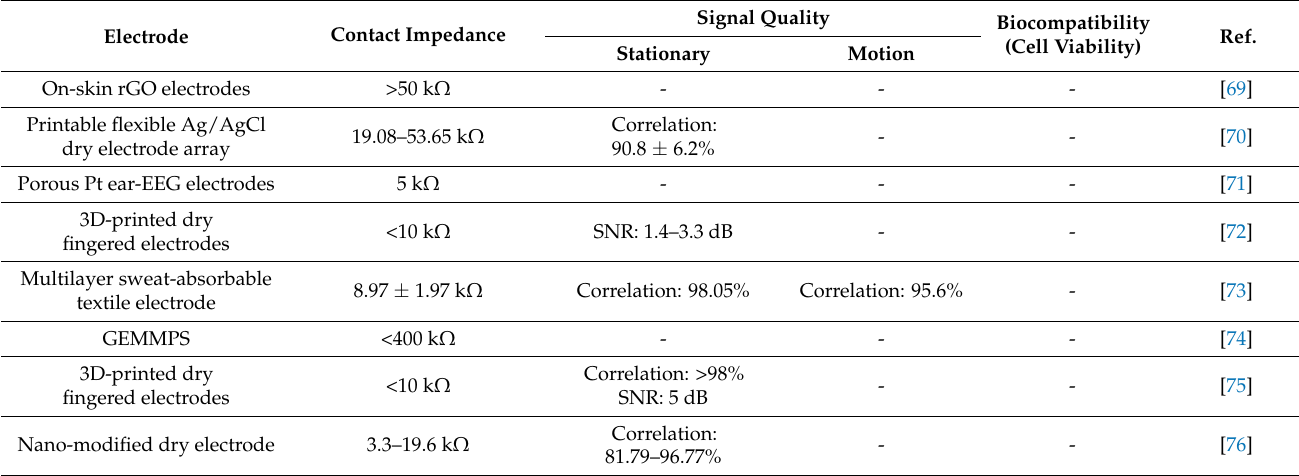
Table A4. Comparison of performance of the selected dry contact EEG